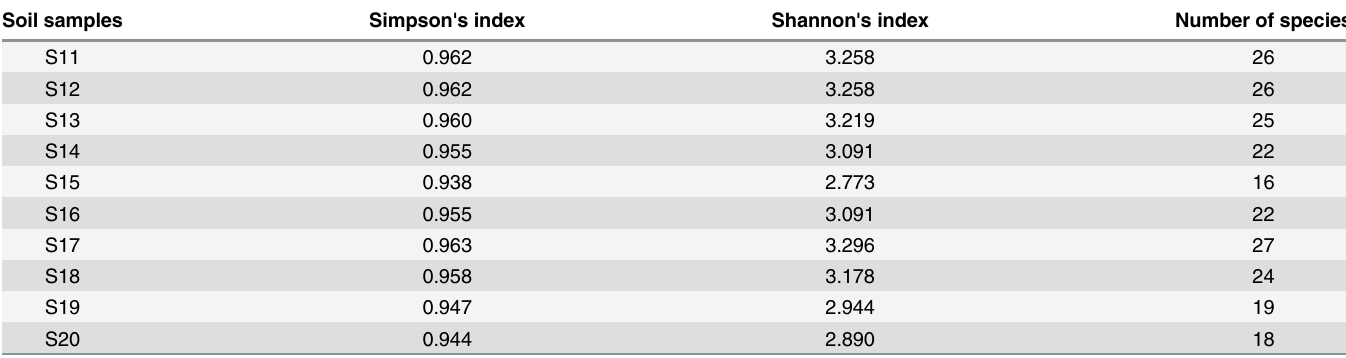
Soil samples were labeled as Table 2. S11, Hulled oat, S12, Mung bean, S13, Foxtail millet, S14, Barley, S15, Rape, S16, Sun fl ower, S17, Carrot, S18, Flax, S19, Naked oat, S20, Tobacco. Indices from different samples in sole cropping system were compared by using Duncan's multiple comparison. Signi fi cant differences were observed among all soil samples ( P <